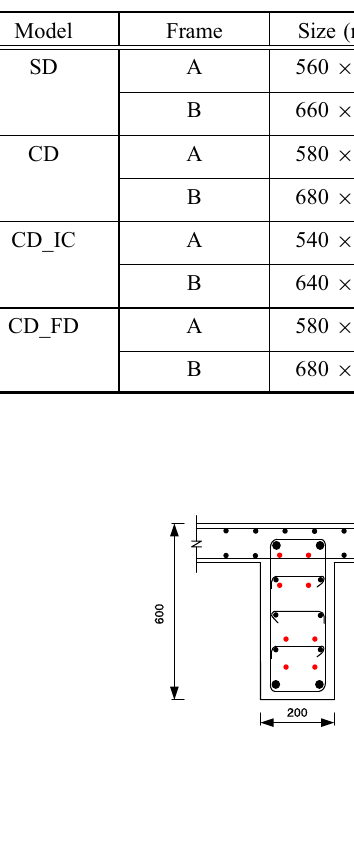
Fig. 2 Structural plan and elevation of the analysis model structure. a Structural plan and b elevation. Table 1 Member size and rebars of the first story exterior columns.